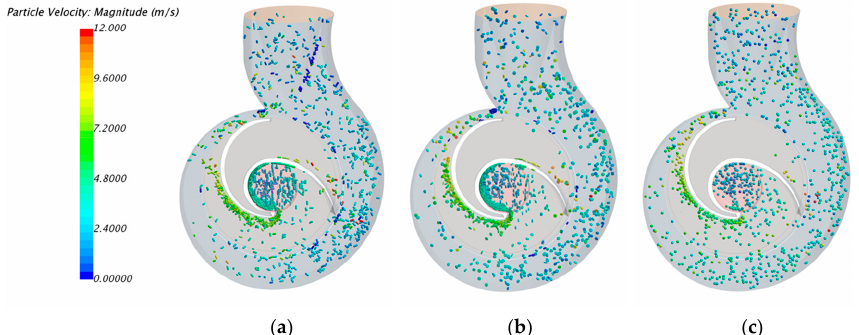
Figure 10. Trajectory and distribution of three distinct ‐ shaped particles ( a ) cylinder practice; ( b ) pie ‐ shaped particle; ( c ) spherical particle. ( b ) pie-shaped particle; ( c ) spherical